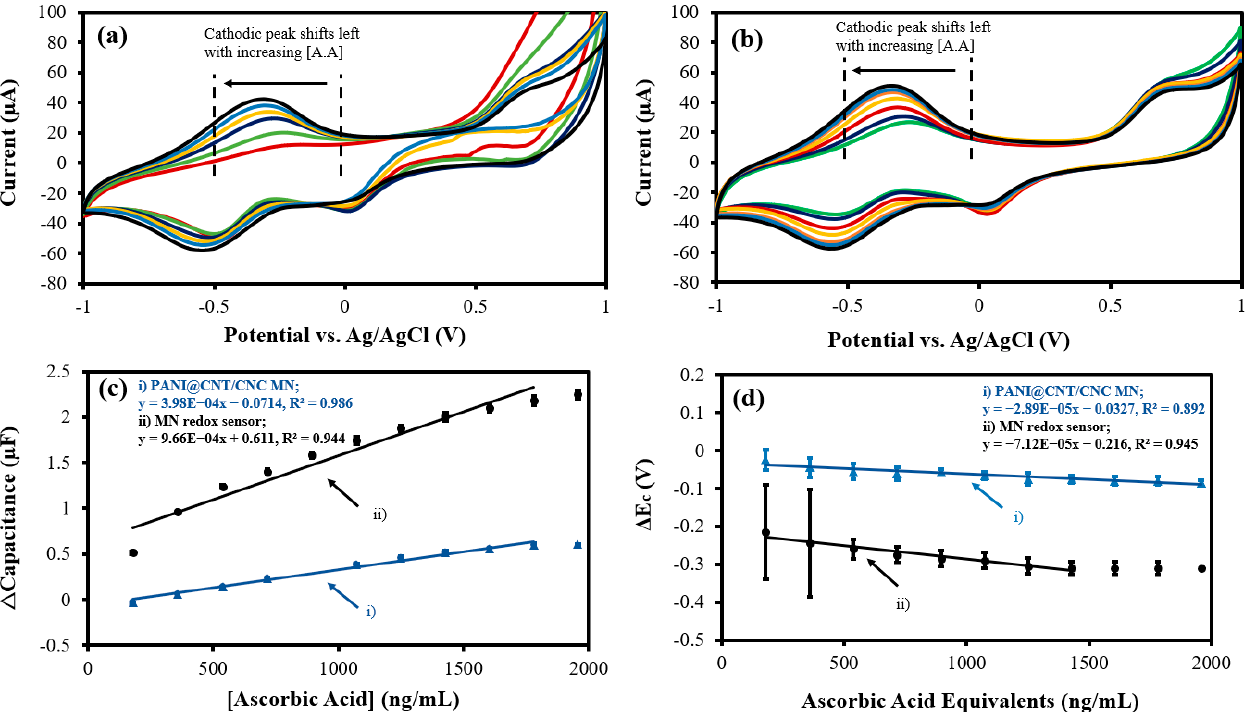
Figure 5. Representative overlapped CVs showing ( a ) MN redox sensor; and ( b ) PANI@CNT/CNC microneedle (MN) electrochemical response to 180–1.96 × 10 3 ng/mL ascorbic acid (A.A) and result-